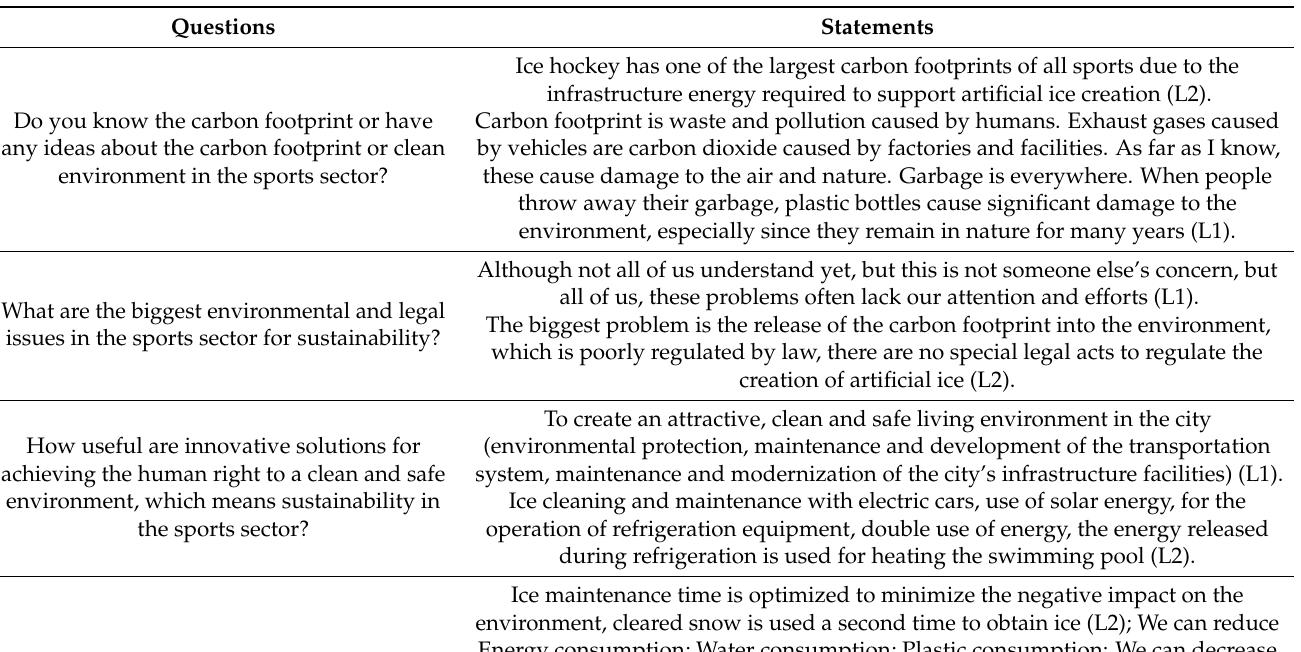
Table 4. Lithuanian Managers’ opinions on the problems and solution